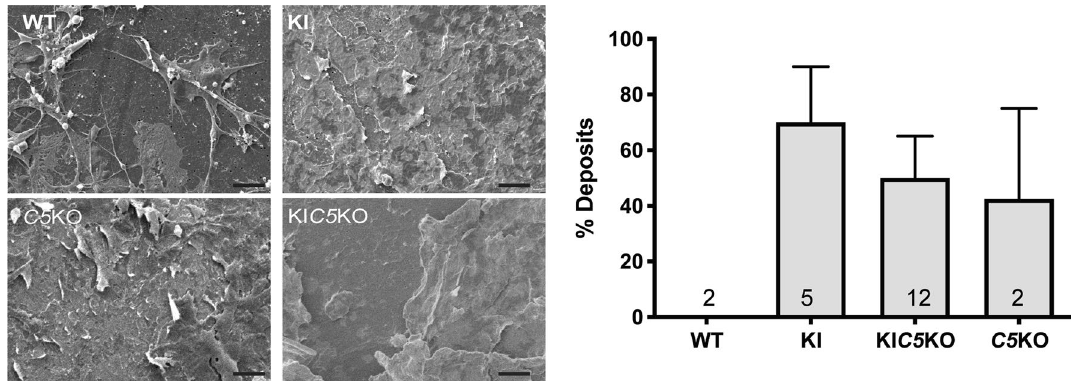
Figure 3. SM images of flat mounts of the bottom side of the transwell show filopodia that extend from the upper side through the pores of the insert in the Efemp1 WT/WT : C5 + / + cultures (WT), vs. deposition of extracellular material in Efemp1 R345W/R345W : C5 + / + (KI), Efemp1 R345W/R345W : C5 -/- (KI C5 KO) and Efemp1 WT/WT : C5 -/- ( C5 KO) cultures . The graph represents the percentage of deposits measured in SM images using a pinpoint technique (see methods section). Data represented as average ± SEM, the numbers inside the bars indicate the amount of cultures used for quantification for each genotype. Scale bar = 10 μm. N = 2 Efemp1 WT/WT :C5 + / + (WT), n = 5 Efemp1 R345W/R345W : C5 +/+ (KI), n = 12 Efemp1 R345W/R345W : C5 -/- (KIC5KO), n = 2 Efemp1 WT/WT : C5 -/-